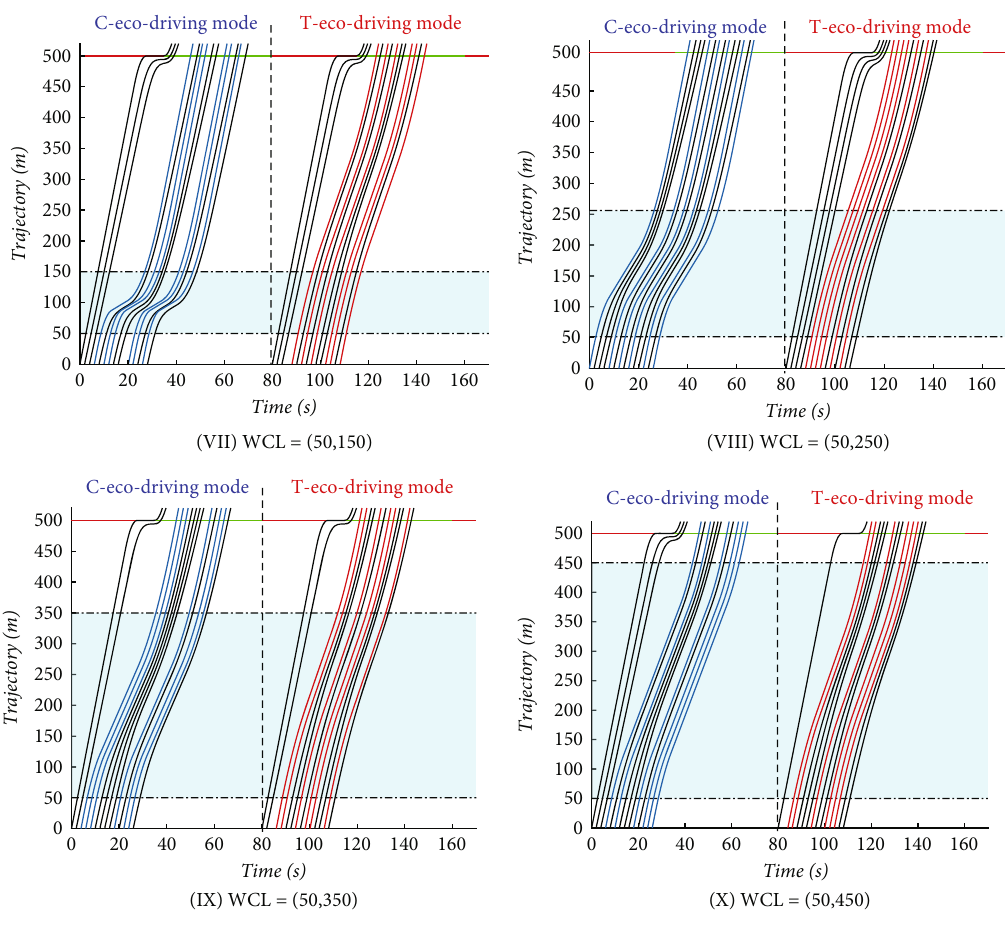
Figure 6: Spatial-temporal trajectories of four conditions (VII ~ X).